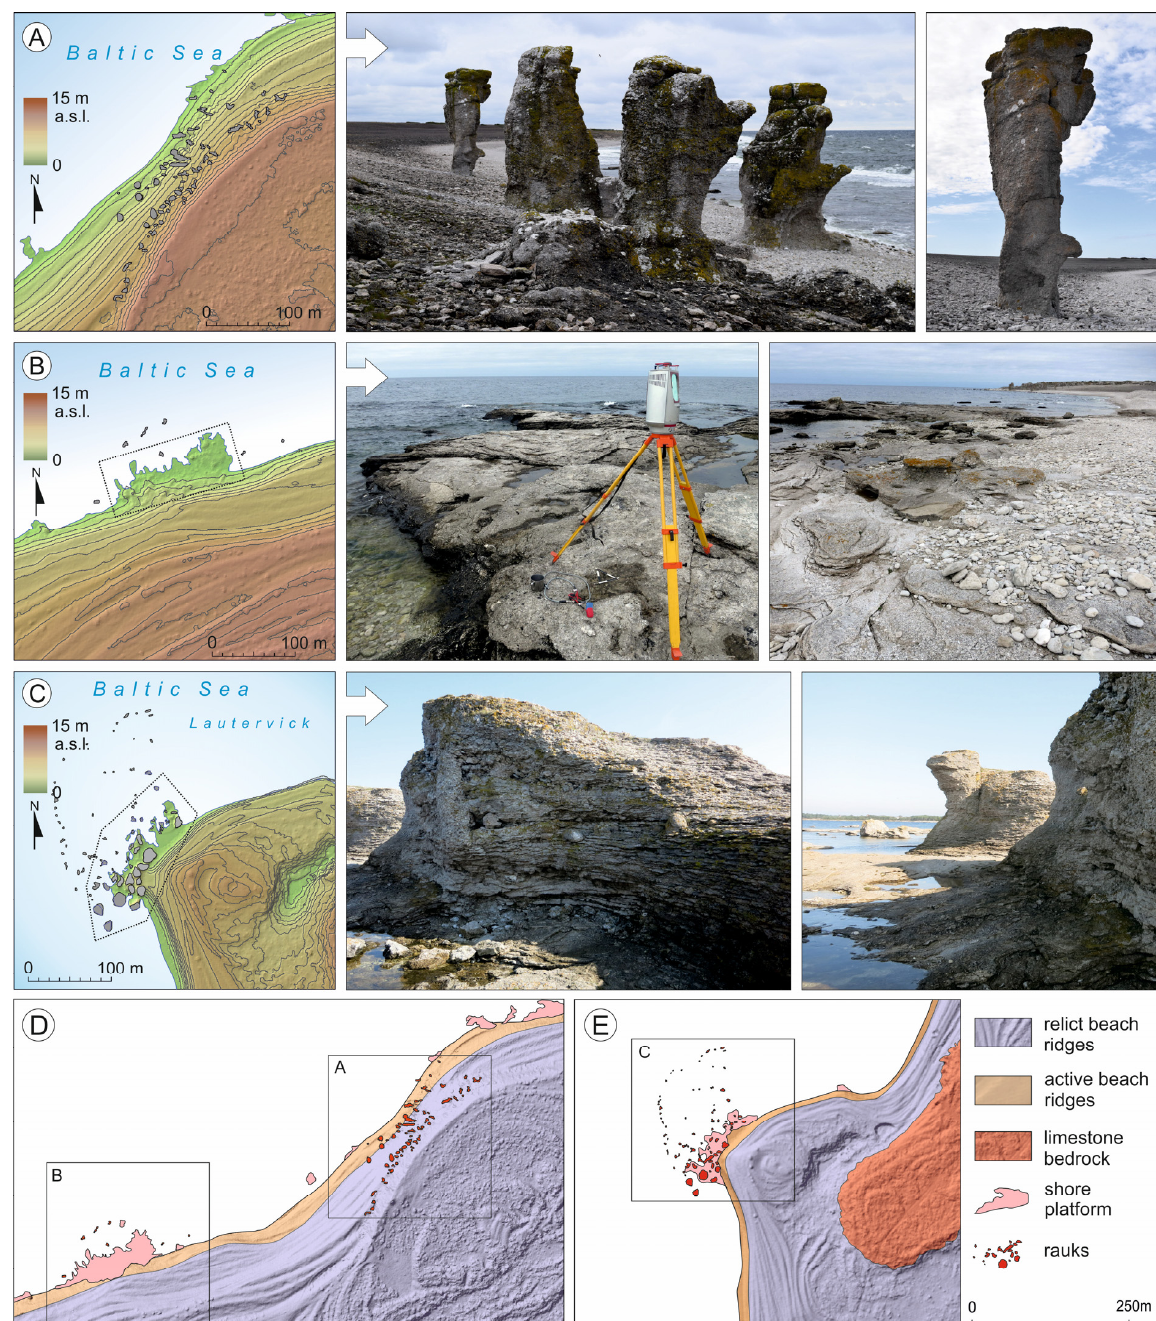
Figure 3. Location of study areas with diverse coastal landscape: ( A ) rauk fields in Langhammars surrounded by shingle beach ridges of Langhammars (LR); ( B ) shore platform developed in limestone of Langhammars (LP); ( C ) rauks and rocky cliffs at Gamla Hamn; ( D ) geomorphological map of Langhammars; ( E ) geomorphological map of Gamla Hamn.